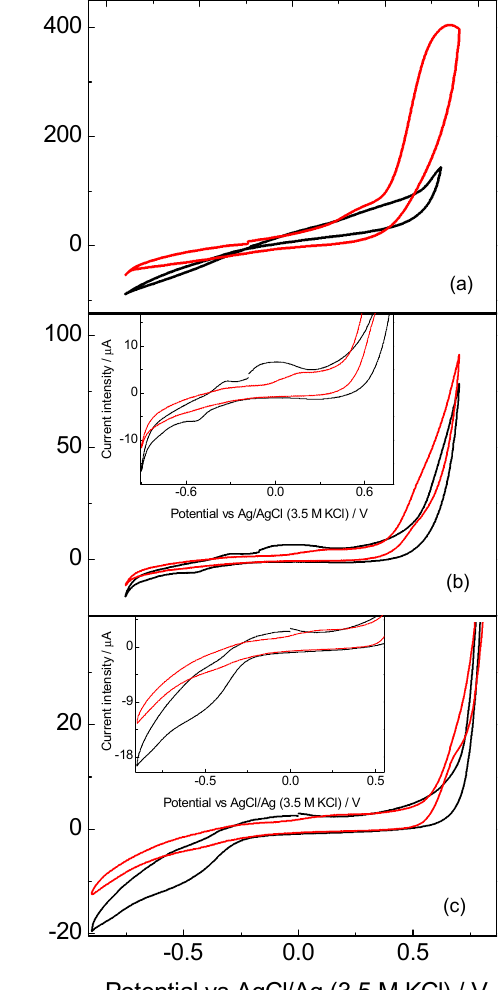
Figure 7. Cyclic voltammograms of the electrochemical response of ( a ) 4VP/CMCu, ( b ) 4VP/CMCuGr, and ( c ) 4VP/SCu with 12 wt.% 4VP ionomer cast onto a GCE in the absence (black line) and presence of 0.02 M PGA (red line) in 0.1 M NaOH. Scan rate 10 mV s − 1 . Third scan recorded. Inset Figures: 4VP/CMCuGr voltammogram ranges from − 0.8 V to 0.8 V, and 4VP/SCu voltammogram ranges from − 0.7 V to 0.5 V positive scan direction, respectively.